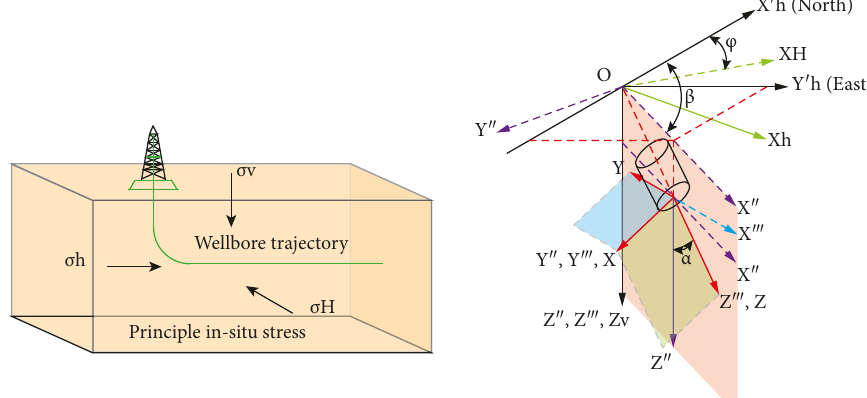
Figure 3: The coordinate rotation processes: (a) stress state of a horizontal well and (b) coordinate transformation system. Principal in situ Y Z ; geodetic coordinate system, X ′ Y ′ Z ′ ; coordinate system, X ″ Y ″ Z ″ after the second time rotation; stress coordinate system, X H h y coordinate system, X ″′ Y ″′ Z ″′ after the third time rotation; local wellbore coordinate system, XYZ ; wellbore deviation angle, α ; wellbore azimuth angle, β ; the maximum horizontal stress azimuth angle, φ